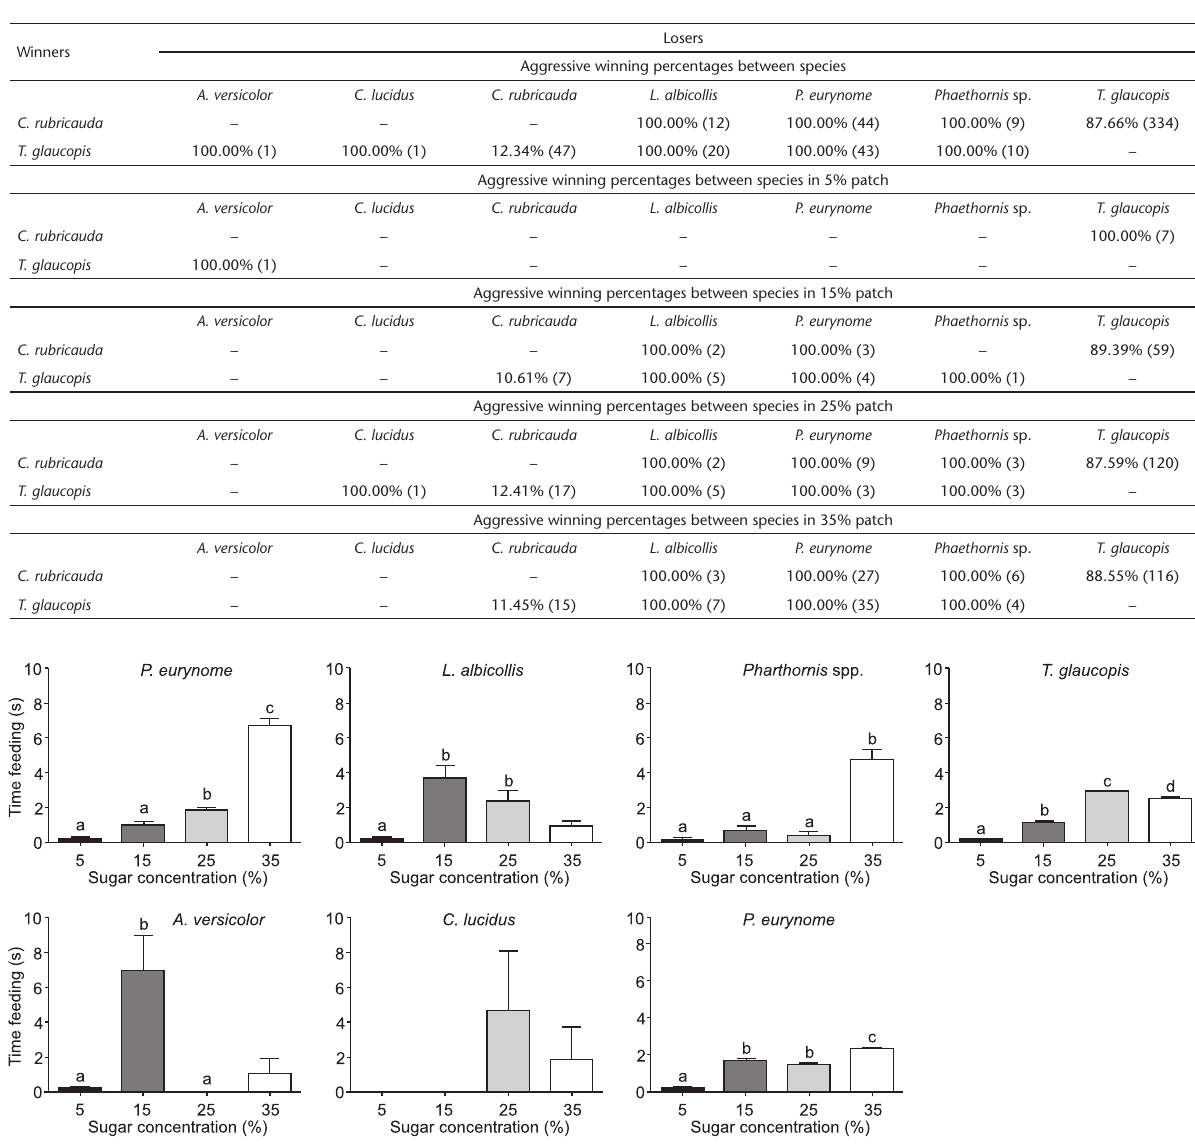
Figure 1. Sugar concentrations most visited by the recorded hummingbird species based on time spent foraging (mean duration of time spent foraging ± SD). Different letters represents statistical differences between sugar solutions as per the results of Dunn’s post hoc tests (P-value <